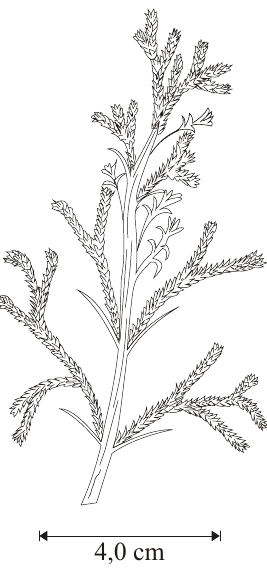
Fig. 7 – Reconstruction of the branching system of Coricladus quiteriensis sp.